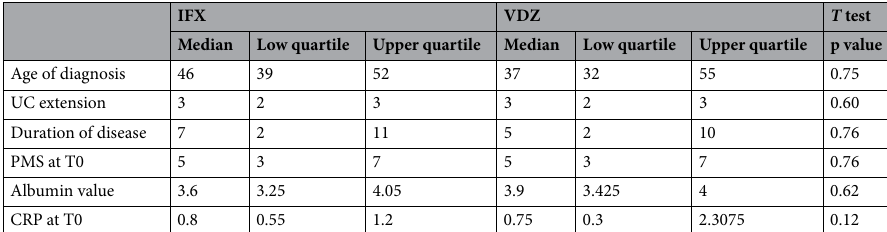
Table 2. Clinical characteristics of the study populations after propensity score